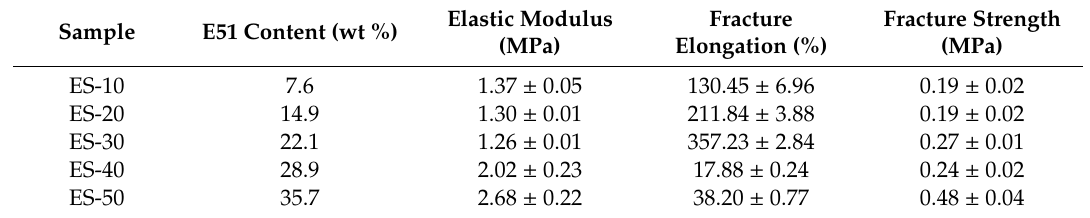
Table 4. Tensile properties of coatings.